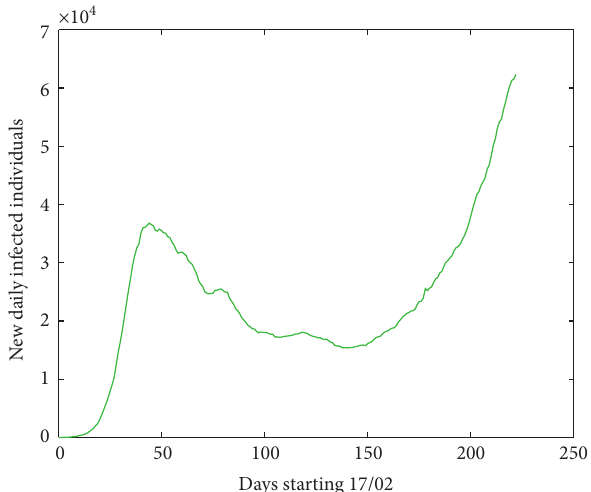
Figure 4: Number of new daily infected individuals in Europe, starting 17 February 2020 up to 30 September